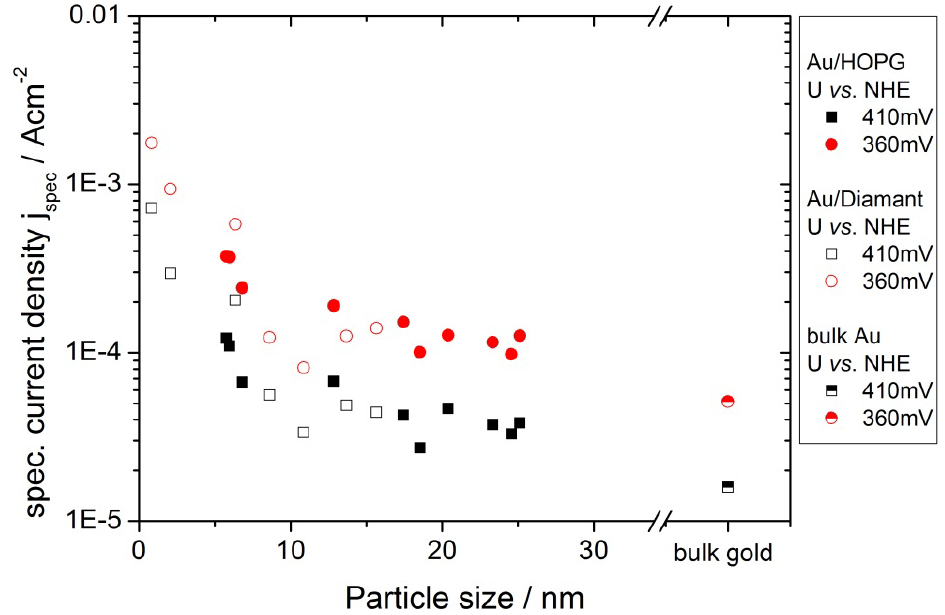
Figure 7. Comparison of the ORR specific current density for Au/HOPG (filled symbols) and Au/diamond (open symbols). The current densities versus particle sizes are comparable for the two substrates. The data for an extended gold surface was added as a reference.